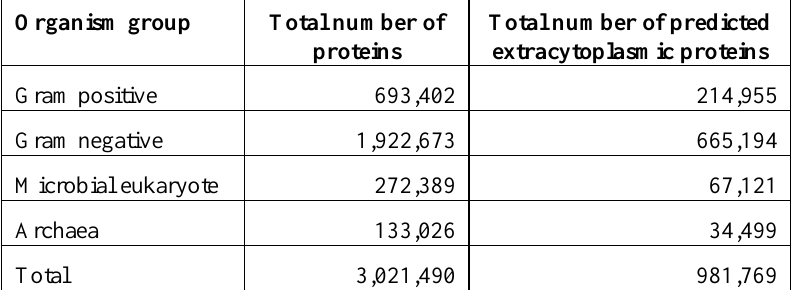
Table 3: Summary of protein sequences assigned to different classes by the extracytoplasmic classification workflow. The workflow was applied to all protein sequences deposited in the GenomePool database. Results are shown in relation to organism groups depending on the major cell surface structures. The Gram-positive group includes members of bacterial phyla Actinobacteria, Firmicutes and Tenericutes. Other bacterial phyla are considered to belong to the Gram-negative